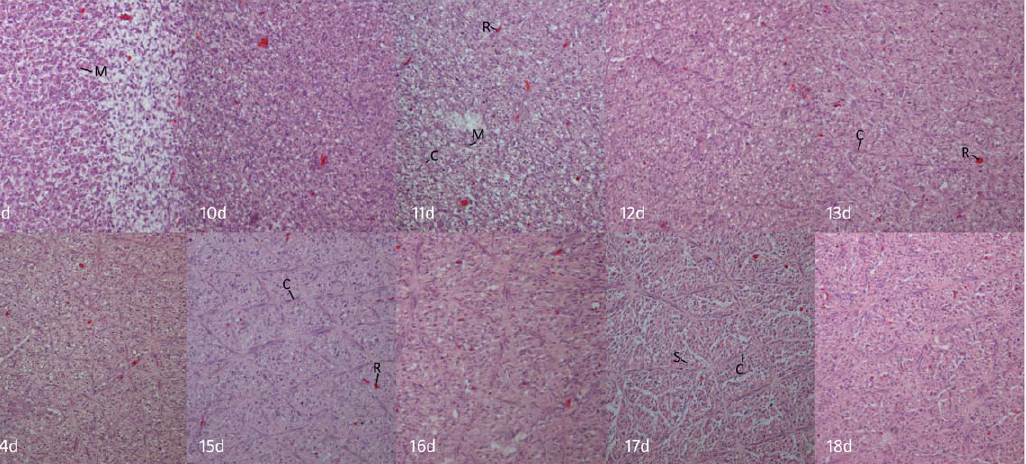
Figure 3. Histological specimens of chick embryonic gizzard at day 9 to day 18 of incubation. (200 6 magnification). Collagen bands and trellis-like muscle bundle confirmed at 11 day of incubation enlarges in subsequent days. Key : C : collagen band, M : myoblast, R : red blood cell, S : smooth muscle.